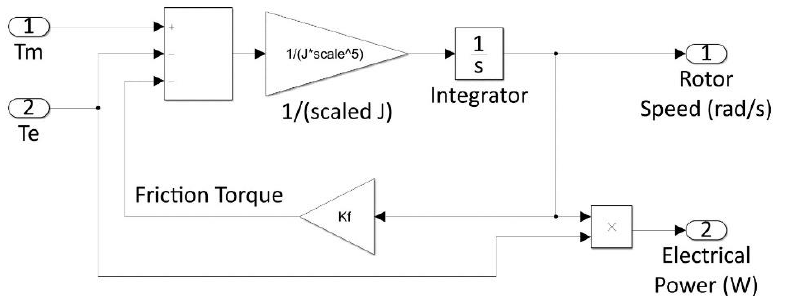
Figure 9. Simulink model of the drive train.